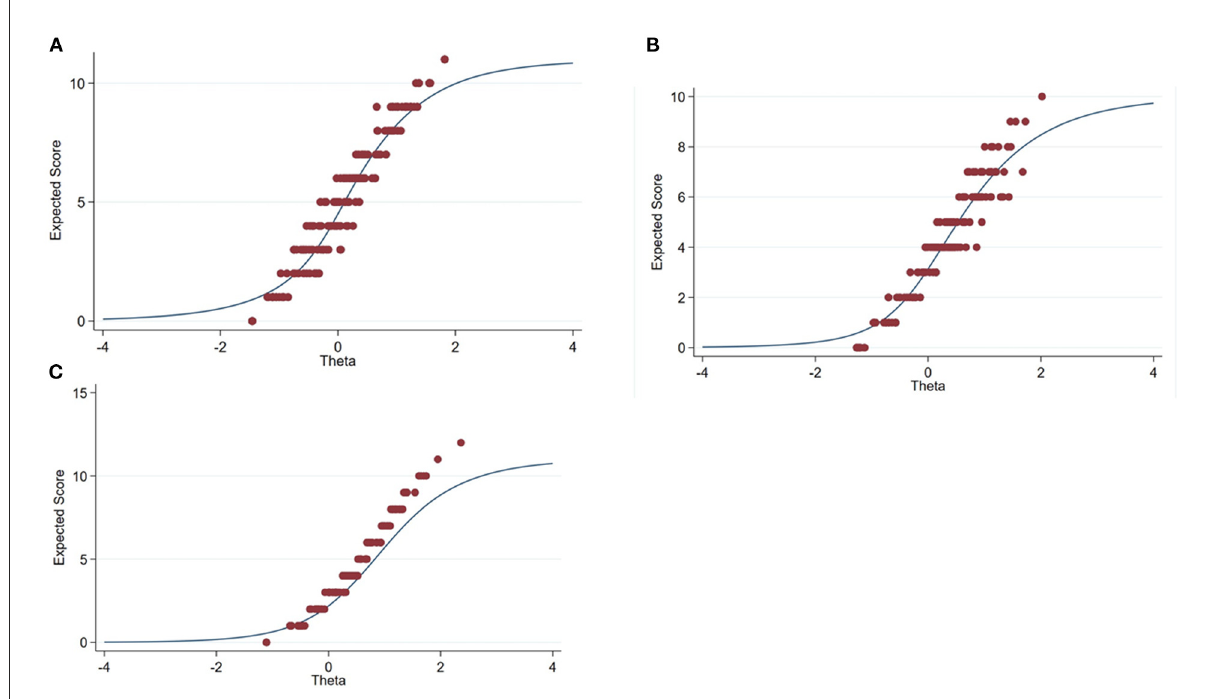
FIGURE4 Test characteristic curve for animal welfare knowledge (A) , attitude (B) , and practice (C) with an added plot (red spots) of the summated score vs. ability (predicted score). Blue line indicates “expected score” and red dot indicate “total score.” Observed total score and expected score showed good fit for individual with knowledge between − 0.8 and 1.4 and attitude level between − 1 and 1.5 for the scale.